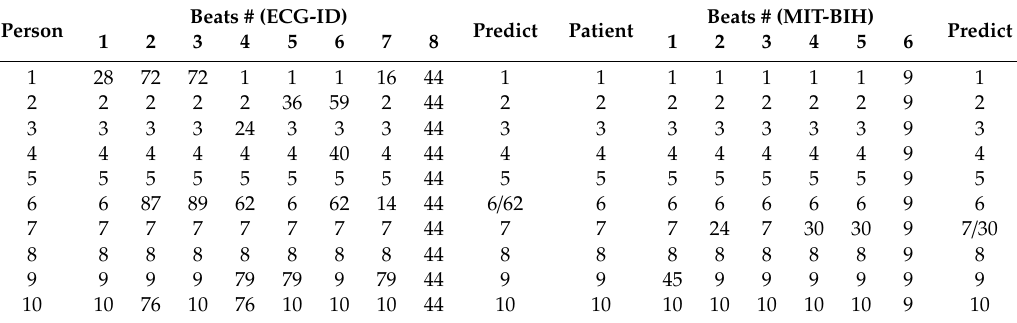
Table 3. Samples of authentication predictions of eight and six ECG beats for the ECG-ID and MIT-BH